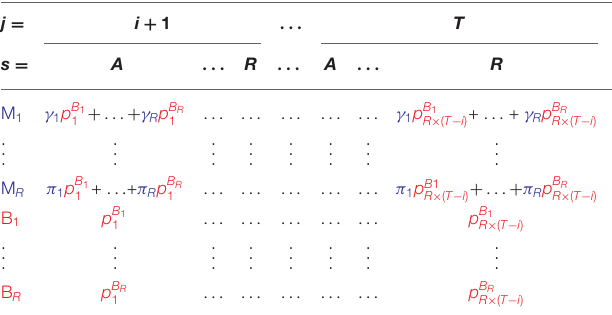
TABLE 4 | Simple model structure of mixtures and associated components used to test the mixture